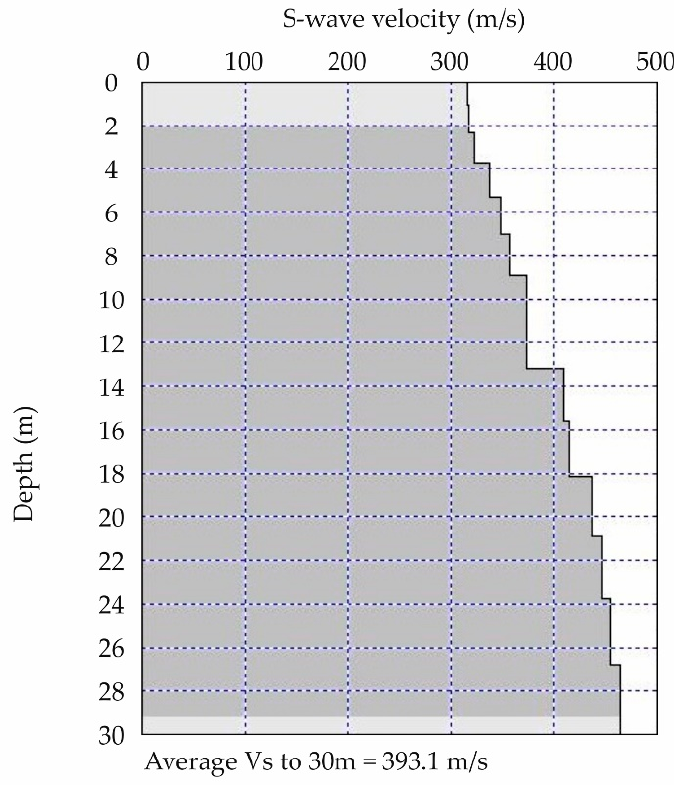
Figure A7. 1D Vs model derived from the MASW technique at EPID station.